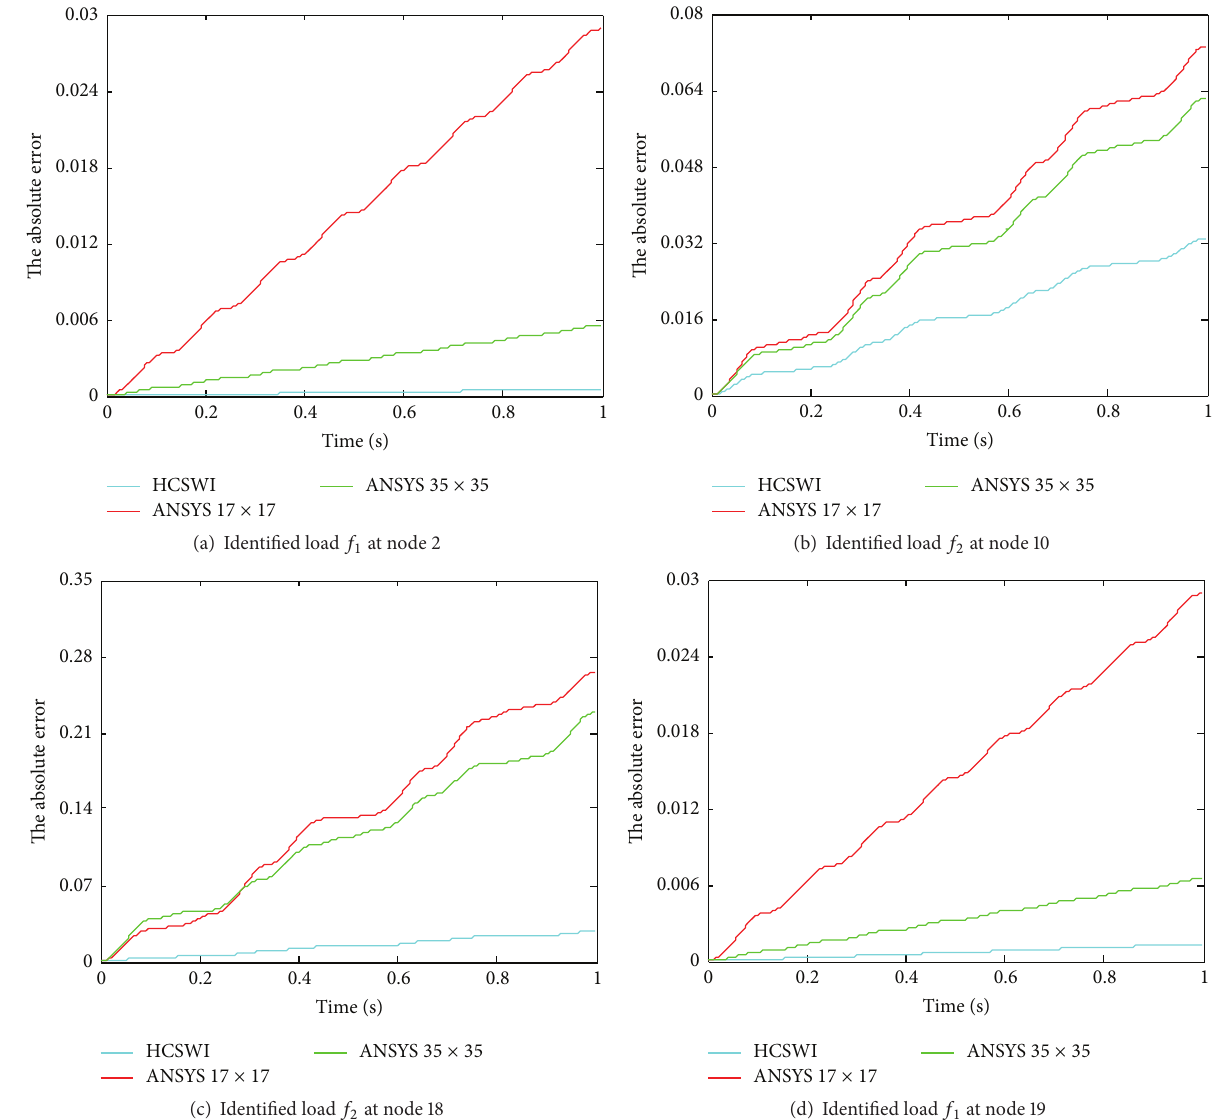
Figure 14: The absolute error with excitation 𝑓 1 and excitation 𝑓 2 applied at nodes 1 and